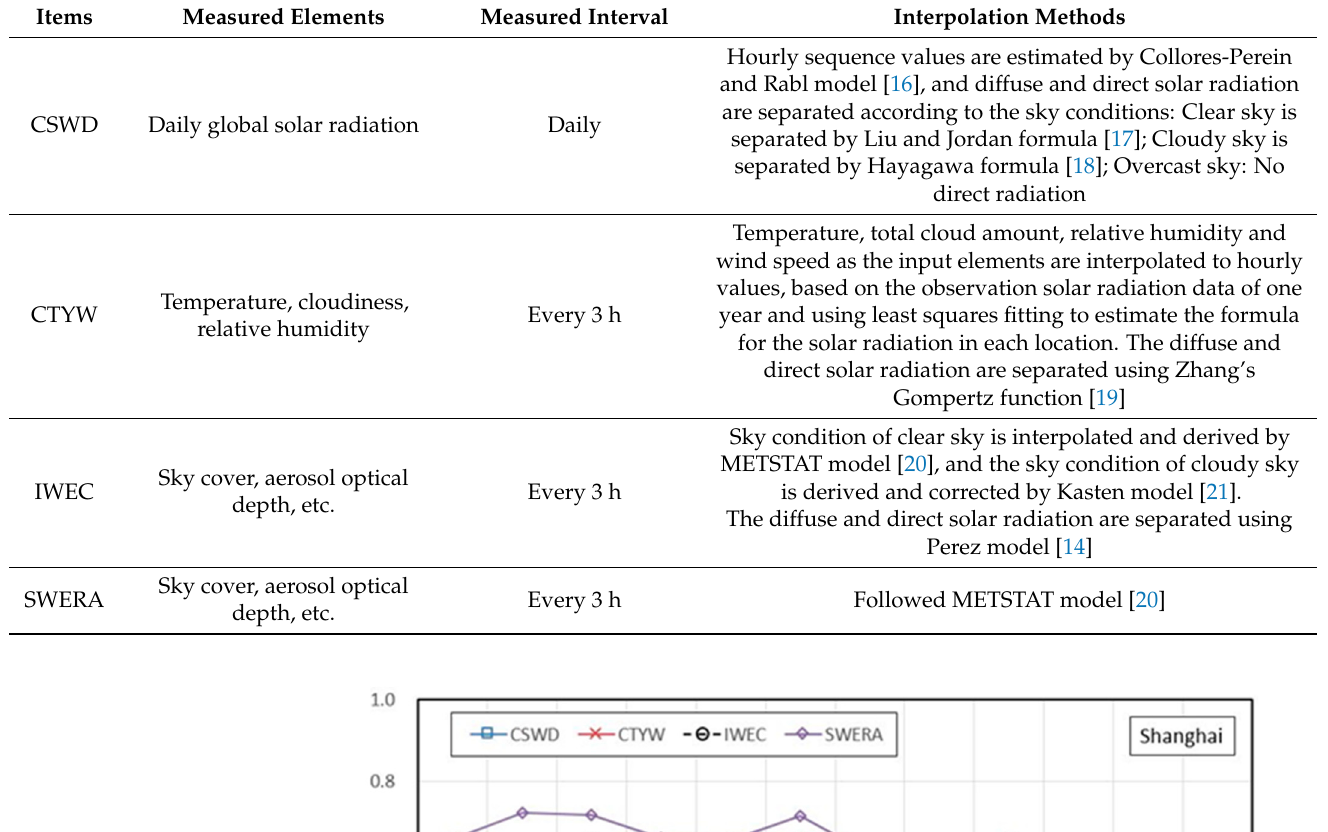
Table 1. Summary of four TMY database to derive solar radiation in China.